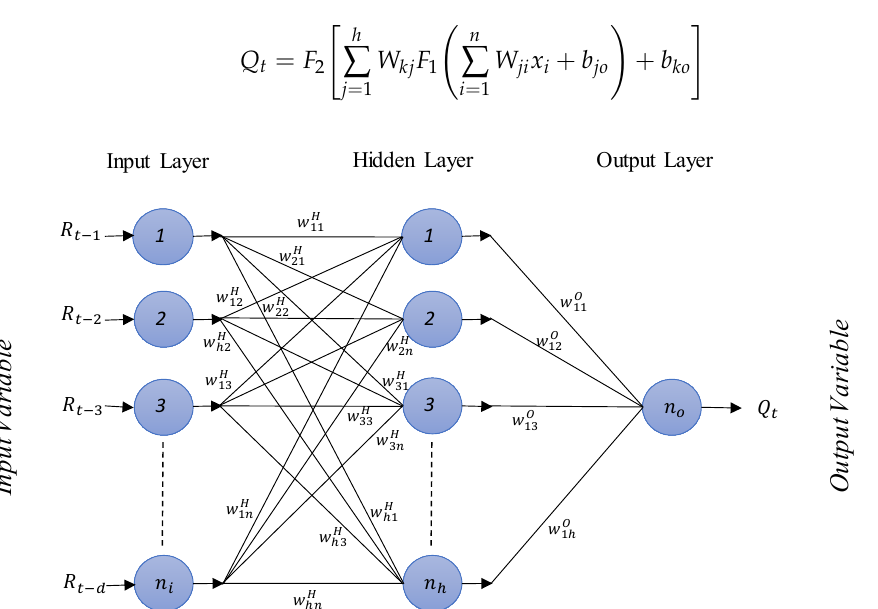
Figure 6. Structure of a general multilayer perceptron (MLP) ANN. Here, Q t is the output of the model that represents the predicted runoff at time t by using rainfall at time t-d as input variables. R t -1 to R t-d is input to the i -th neuron in the input layer, Q t is the output from the k -th neuron in the output layer, F 1 is the hidden layer activation function and F 2 is the output layer linear activation function; b jo and b ko are the bias units of the j -th neuron in input layer and the k-th neuron in the output layer, respectively, and W ji denotes the connection weight of the i -th neuron in the input layer and the j -th neuron in the output